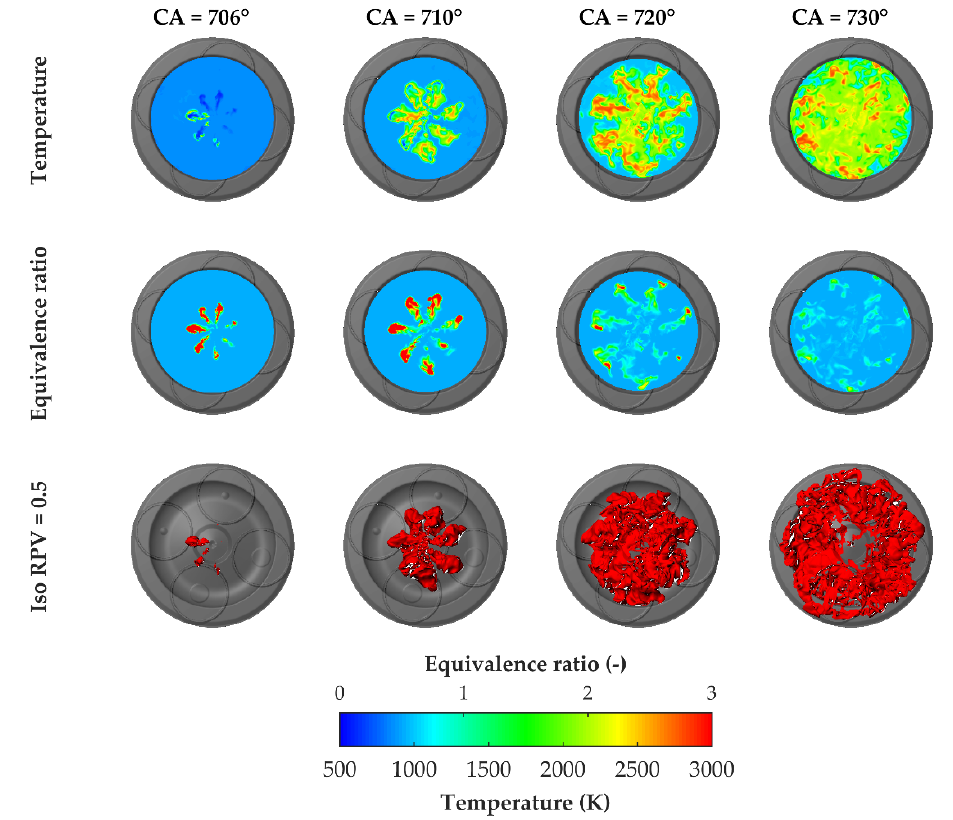
Figure 9. Distribution of temperature, equivalence ratio and reaction progress variable (RPV) in the cylinder for three different crank angles around TDC.